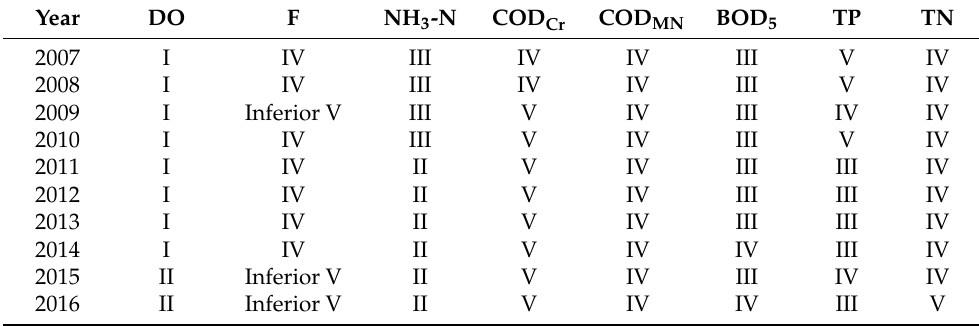
Table 2. Single- factor evaluation results of each indicator in each sample.